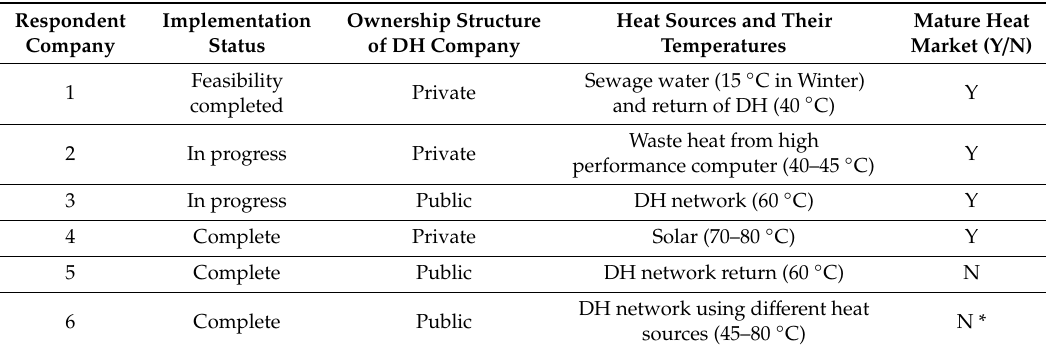
Table 2. The companies included in the case